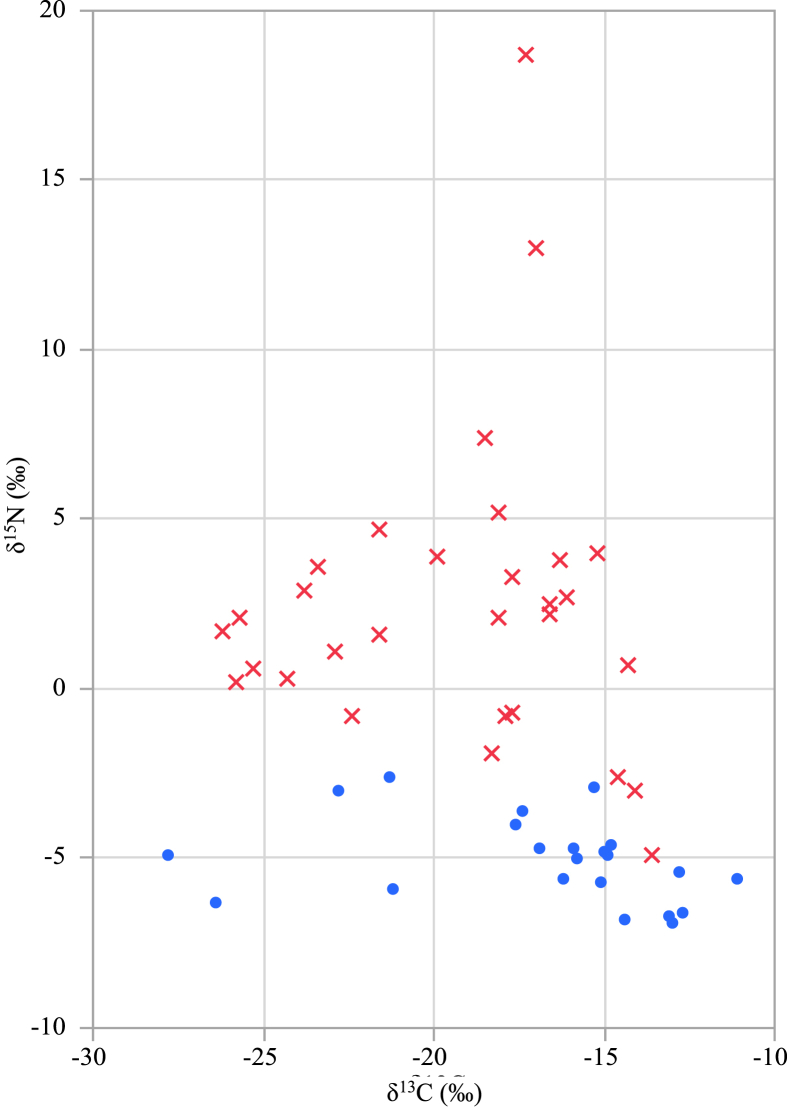
Two-dimensional plot of the δ13C and δ15N values of glutamic acid contained in processed foods. Blue “●” and red “×” show samples to which seasoning MSG was added and samples to which seasoning MSG was not added, respectively.